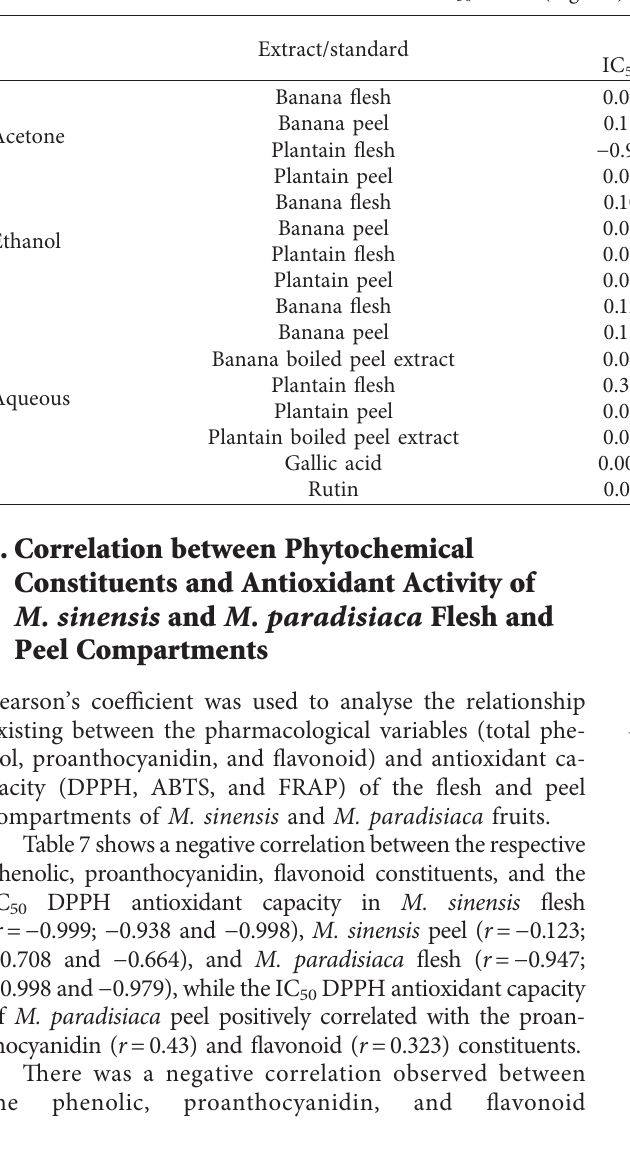
Table 6: IC 50 values (mg/mL) of extracts and standards.